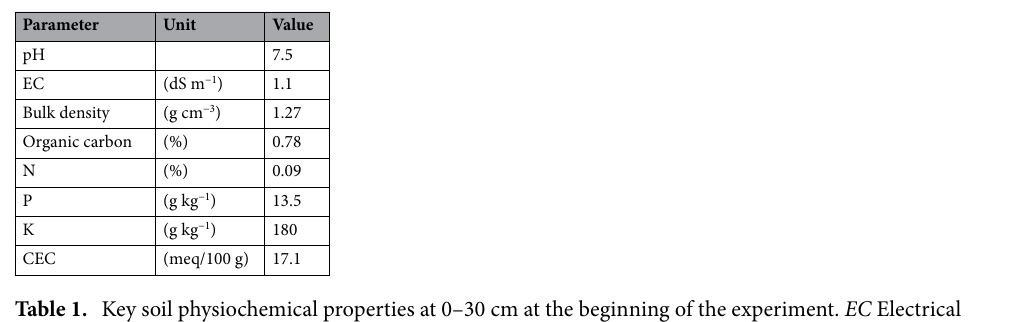
Table 1. Key soil physiochemical properties at 0–30 cm at the beginning of the experiment. EC Electrical conductivity, N Nitrogen, P Phosphorus, K Potassium, CEC Cation exchange capacity.